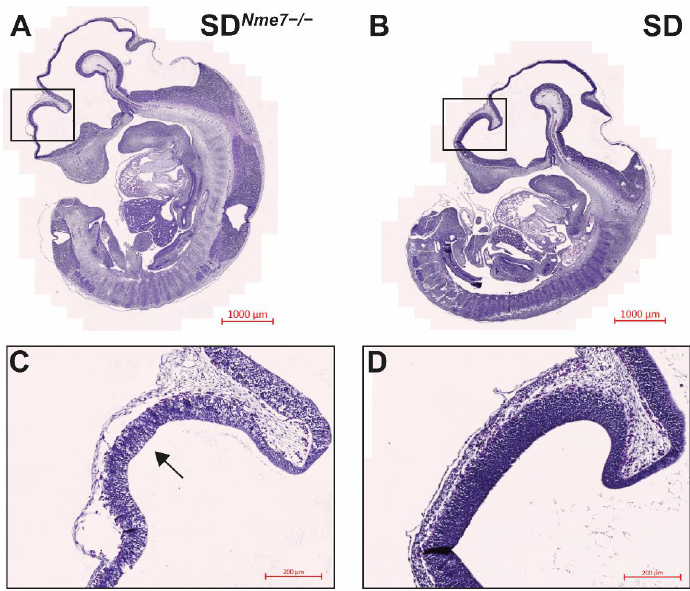
Figure 2. Hematoxylin – eosin-stained mid-sagittal sections of ( A ) SD Nme7 − / − and ( B ) SD embryos at E13.5. Blow-up images ( C , D ) show differences in the developing brain cortex. The SD Nme7 − / − rat embryo shows thinner ventricular zone (arrow) of neopallial cortex, with reduced cellularity in both cortical and thalamic regions. The bars indicate 1000 µ m for ( A , B ) and 200 µ m for ( C , D